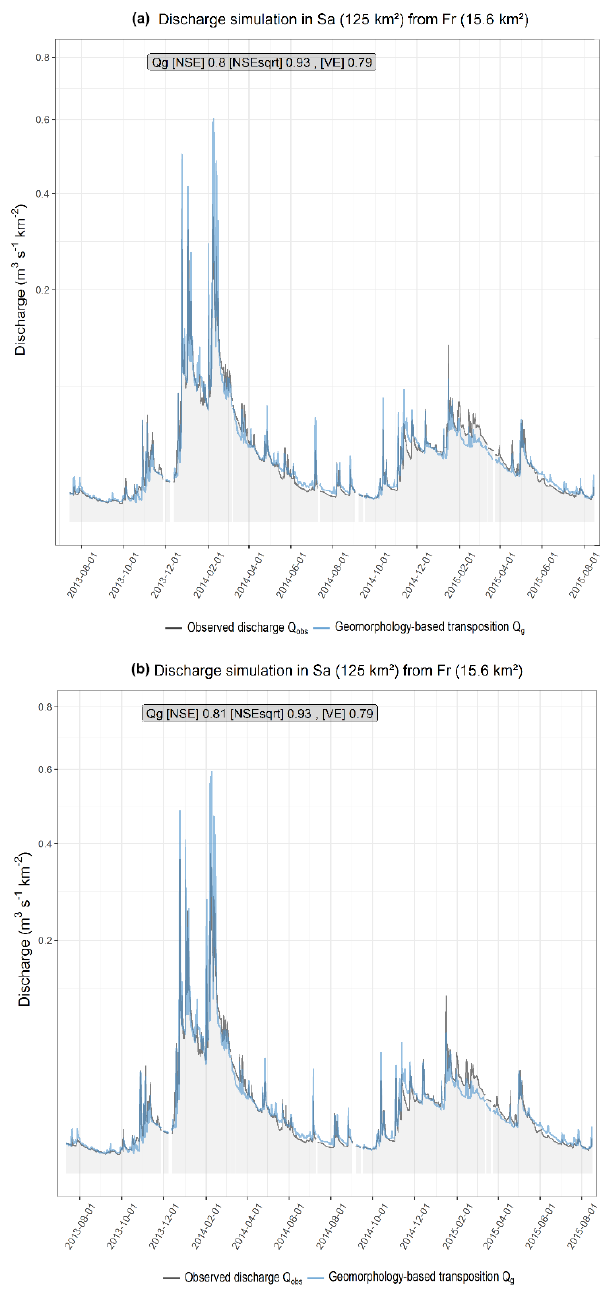
Figure 5. Discharge simulated series in pseudo-ungauged Sa (125km 2 ) from Fr (15.6km 2 ) between 8 January 2013 and 8 Jan- uary 2015, using transfer functions extracted from (a) RGE (5m) and (b) SRTM (25m) – and observed series as a